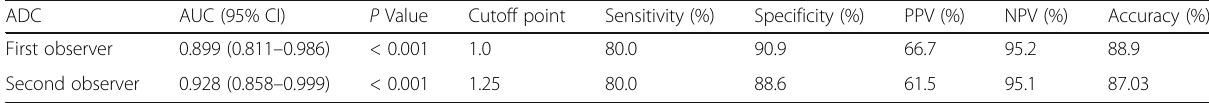
Table 3 Showed the cutoff ADC value between recurrent breast carcinoma and benign post-operative changes by both observers ADC